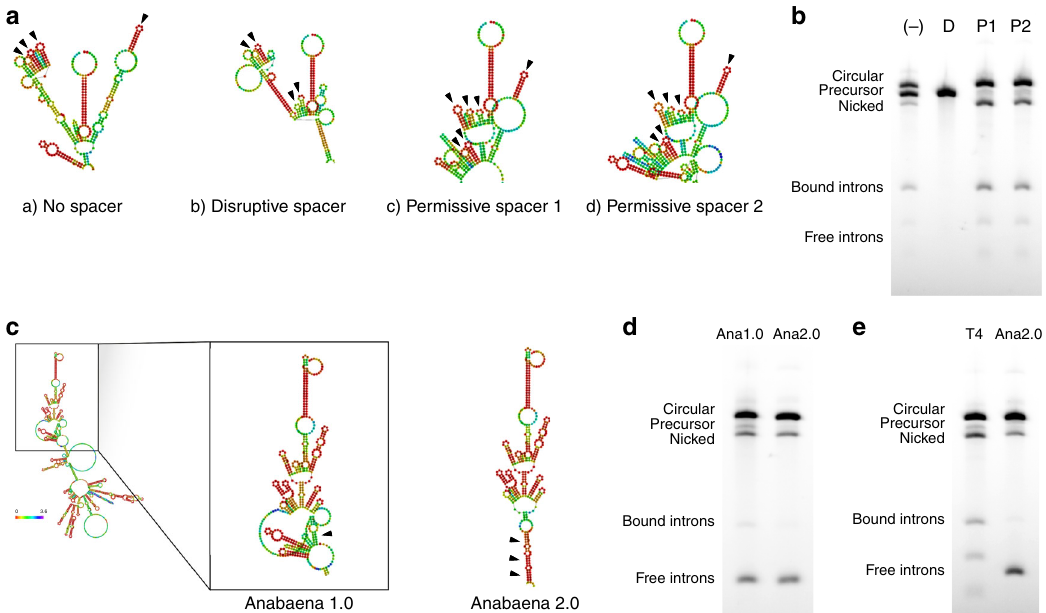
Fig. 2 Spacer design and splicing using the Anabaena autocatalytic intron. a RNAFold predictions of precursor RNA secondary structure in the context of designed spacers. Secondary structures potentially important for ribozyme function are identi fi ed by black arrows. b Agarose gel demonstrating the effect of spacers on splicing. ( − ): no spacer. D: disruptive spacer. P1: permissive spacer 1. P2: permissive spacer 2. c RNAFold predictions of precursor RNA secondary structure for internal homology region design. Lack of signi fi cant internal homology (Anabaena 1.0) and introduced internal homology (Anabaena 2.0) indicated by black arrows. Splicing bubble indicated as the region between homology arms and internal homology regions that contains the splicing ribozyme. d Agarose gel demonstrating the effect of internal homology on splicing. e Agarose gel comparing the optimized T4 phage splicing reaction to the optimized Anabaena splicing reaction. Anabaena intron halves are of roughly equal lengths, and are less likely to remain associated after splicing in comparison to the T4 phage intron halves despite stronger homology